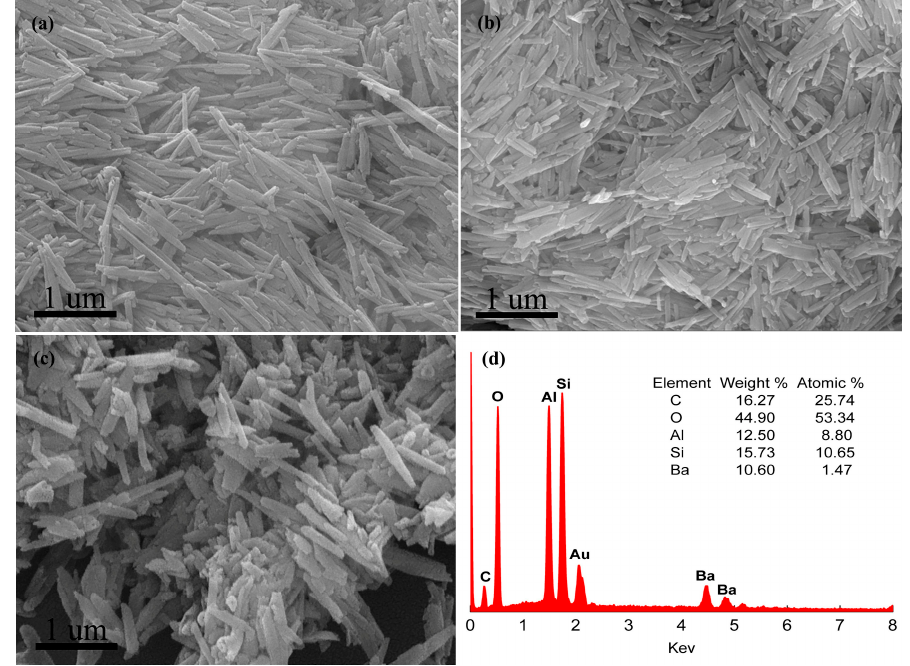
Figure 5. ( a ) SEM image of Hal, ( b ) A-Hal, ( c ) BaCO 3 /A-Hal-T and ( d ) EDX spectrum of BaCO 3 /A-Hal-T.